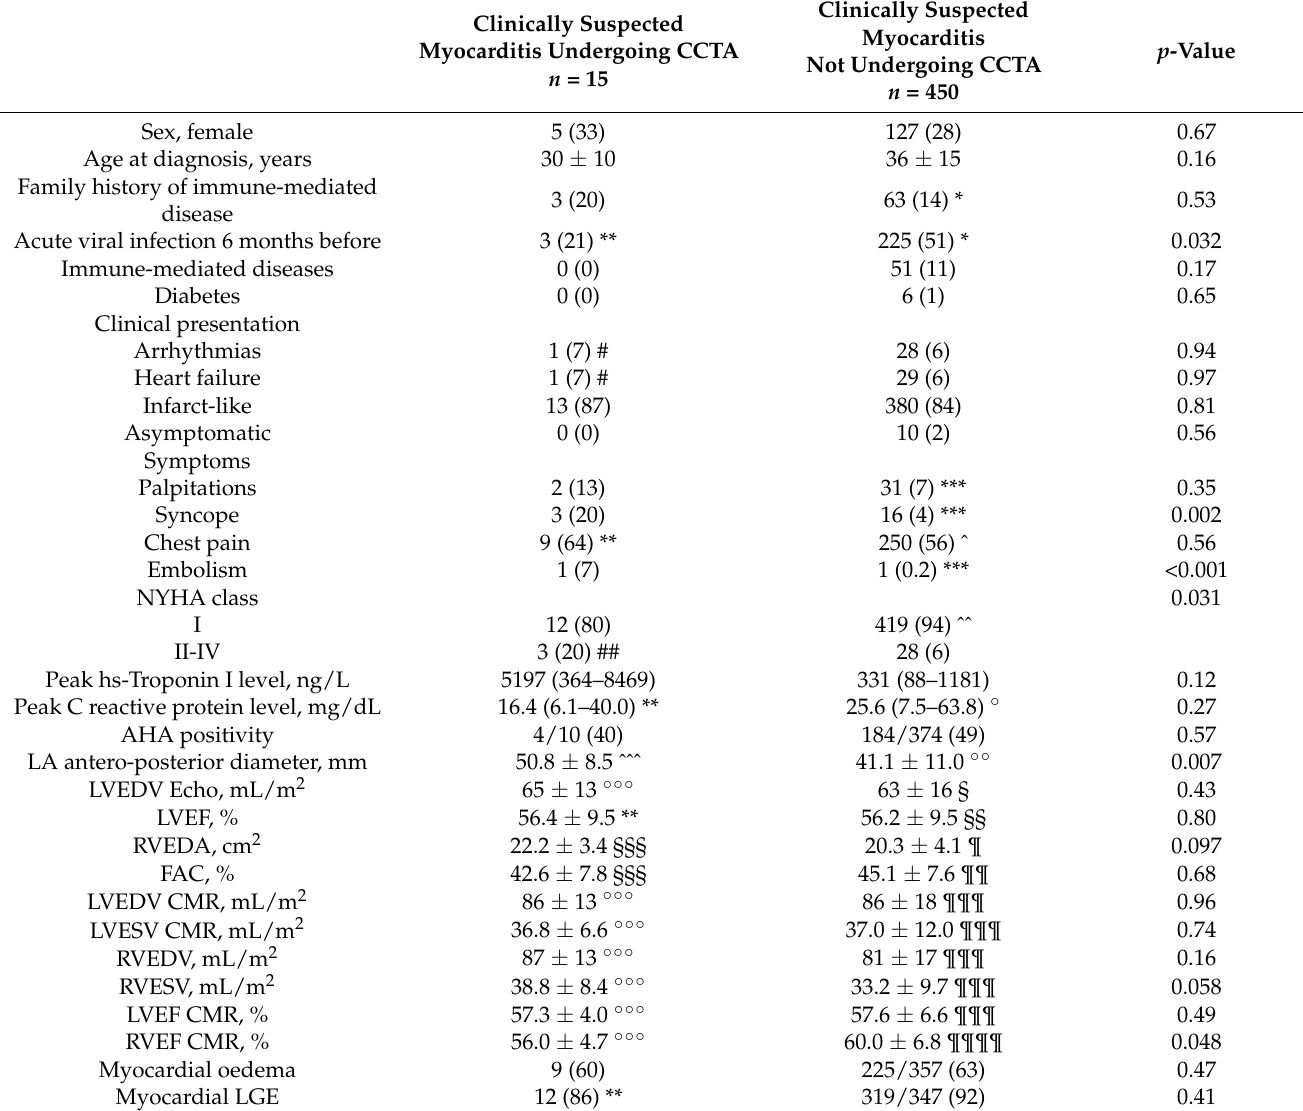
Table 1. Clinical, demographic, laboratory, and imaging characteristics of patients with clinically suspected myocarditis undergoing and not undergoing